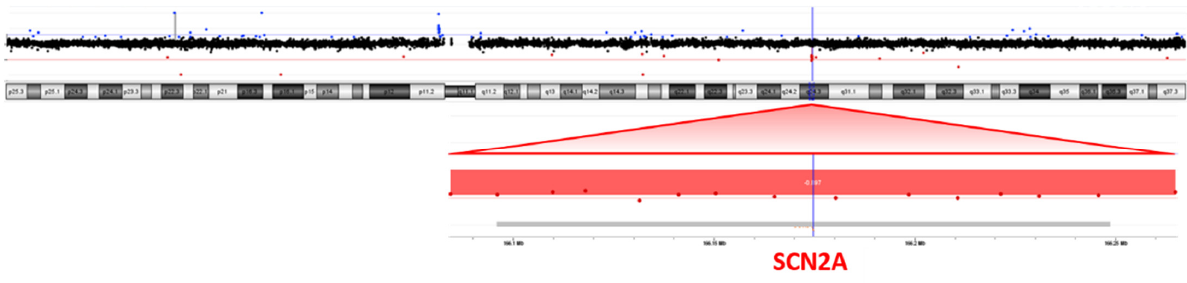
Figure 2. Array-CGH (4 × 180K platform) showing a microdeletion at 2q24.3, spanning 194 Kb of genomic DNA including the entire SCN2A gene.